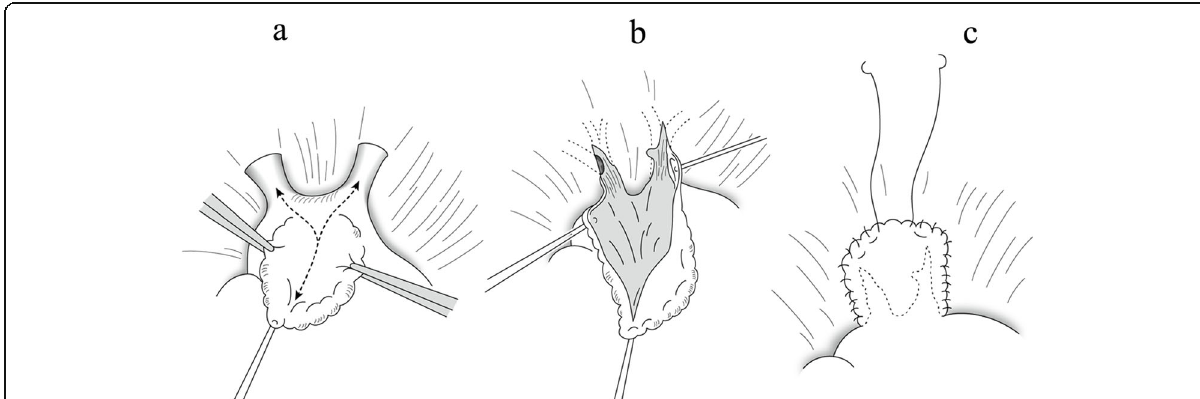
Fig. 4 Schema of surgical procedures (illustration). a The left atrium was incised from the apex of the LAA to the confluence of the PV and proceeded separately to the upper and lower PVs. b The anterior walls of stenosed or occluded lesions were dissected as peripherally as possible. c The left atrium and PV were covered with incised LAA flap using 5-0 monofilament running suture (sutureless